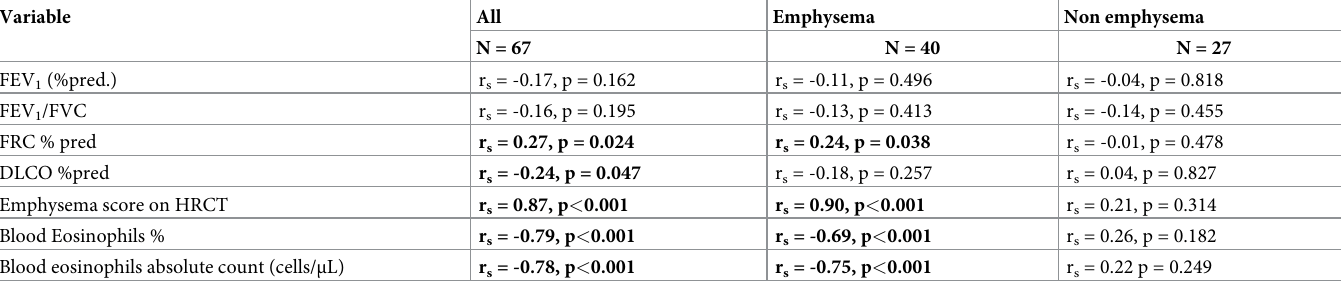
Emphysema score on